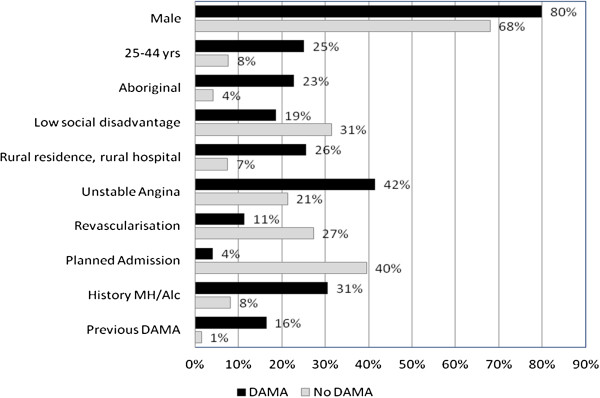
Comparison of the characteristics of IHD patients who did and did not discharge against medical advice (DAMA), WA 2000–2008. History MH/Alc: Admission for mental health or alcohol-related disorder in the previous 5 years. All variables in the table differed significantly between cases that did and did not DAMA.